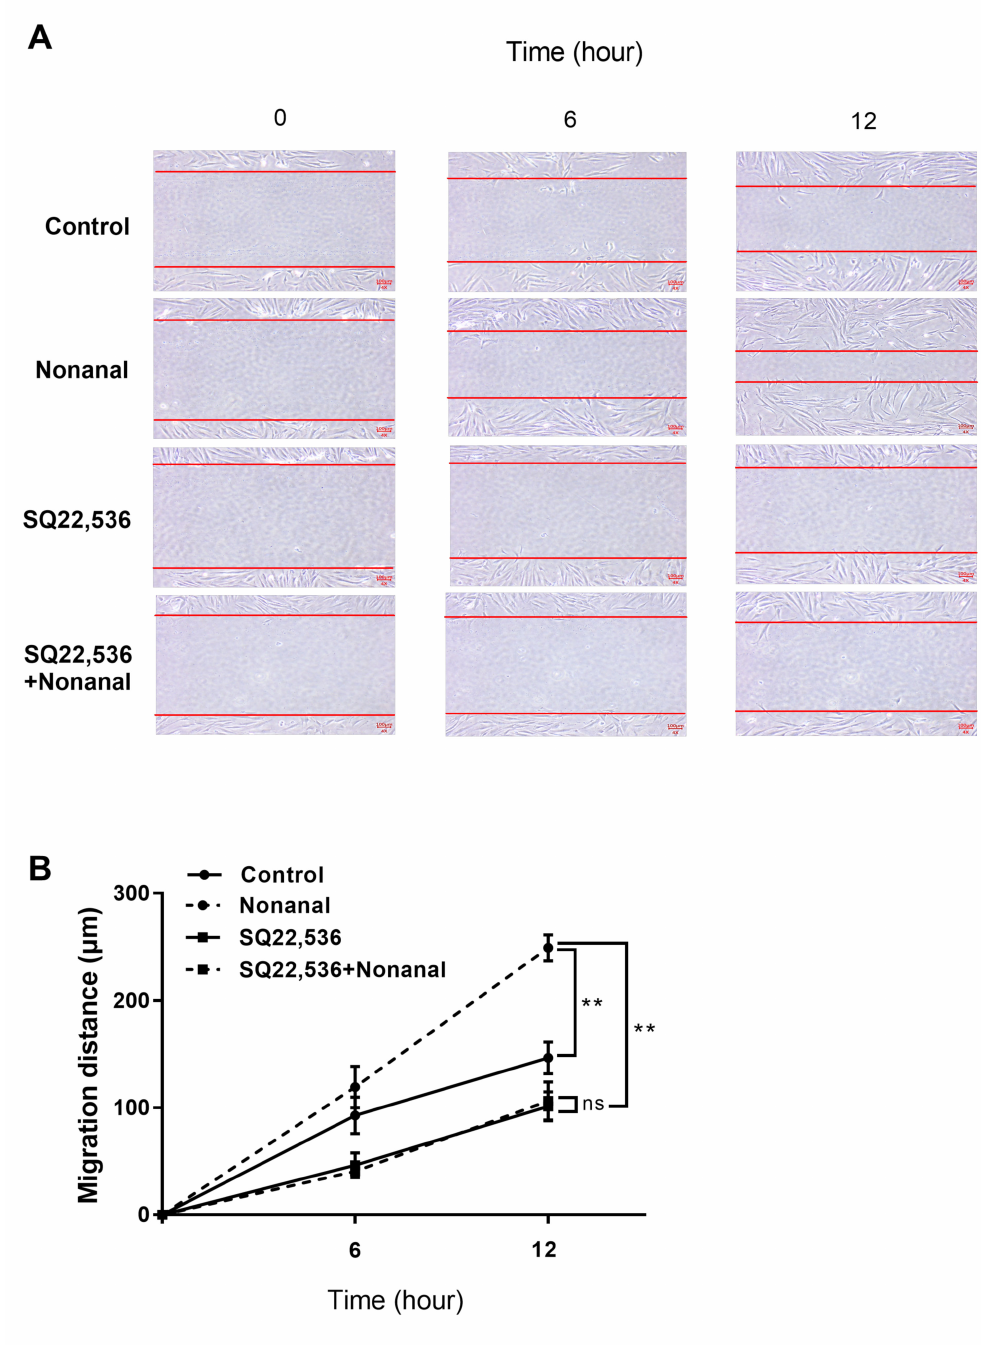
Figure 7. E ff ect of nonanal on DPC migration via the cAMP signaling pathway. Migration assay was conducted in confluent DPCs by drawing a straight line across the bottom of the dish, followed by incubation with either vehicle or 50 µ M nonanal at di ff erent time points (0, 6, and 12 h). The vehicle or 50 µ M SQ22,536 was added 1 h before nonanal treatment. ( A ) Phase-contrast microscopy images of the scratched area were captured. The lines delineate the migrating edges of cells. ( B ) Quantification of cell migration was performed by measuring the area occupied by the cells at di ff erent time points. Data were statistically analyzed using the Student’s t -test. Data are presented as mean ± standard error of mean (SEM) of the results of three independent experiments. ** p < 0.01. ns, not